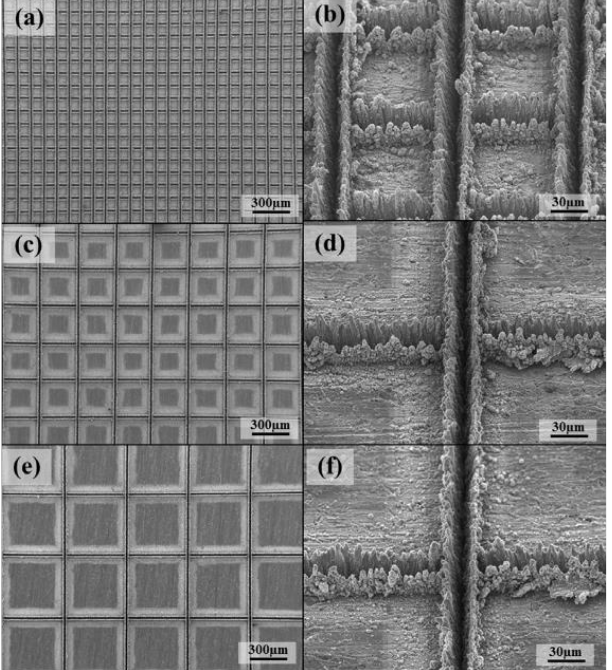
Figure 28. SEM images of laser beam machined surface: ( a ) 100 mm, ( c ) 300 mm, and ( e ) 500 mm, and enlarged images: ( b ) 100 mm, ( d ) 300 mm, and ( f ) 500 mm (Reprinted with permission from Ref. [104]. 2016, Chun, D.M.).